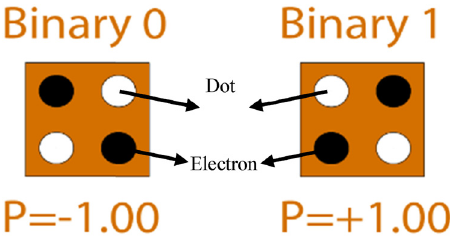
Figure 1: QCA cell con fi gurations.